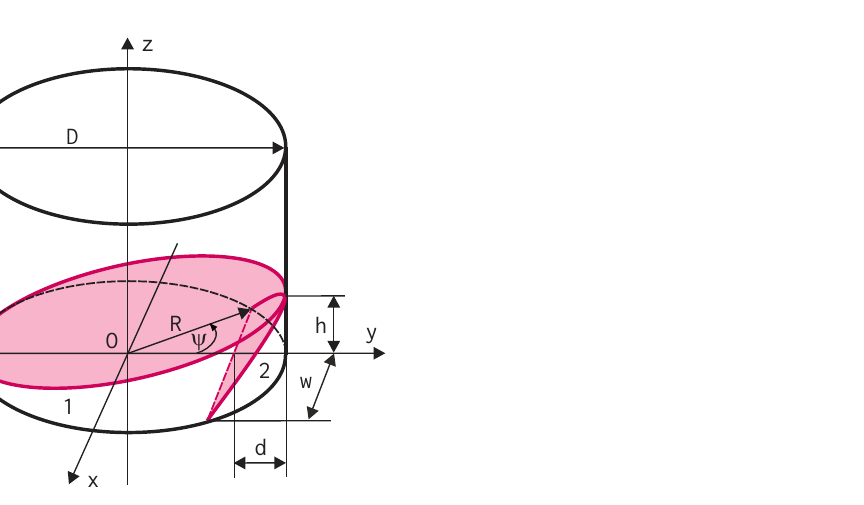
Figure 11. Gaps between the bottom surface of a sample and active area of the sensor: 1) a penetrating gap and 2) a perimetral gap.